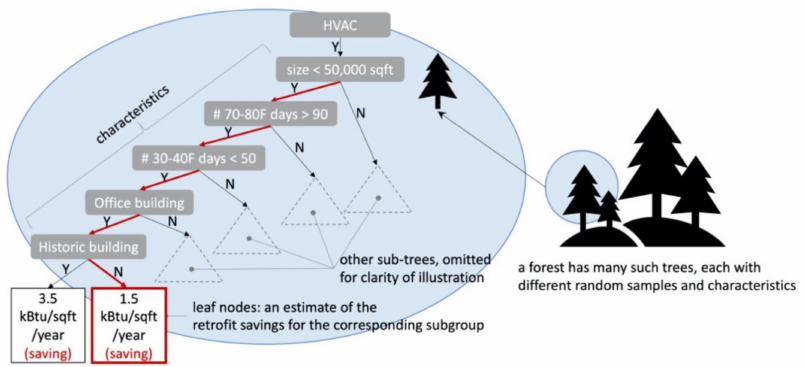
Figure 6. Illustration of a regression tree in the causal forest estimating effects of HVAC